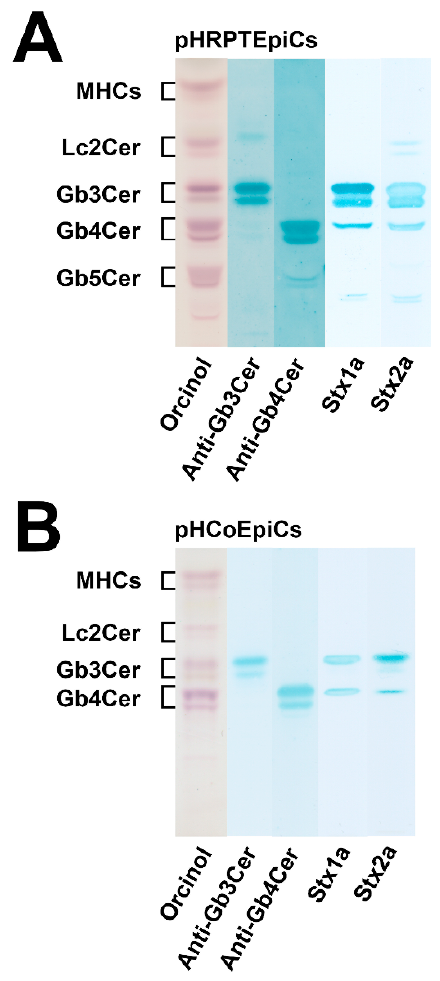
Figure 3. Orcinol stain and anti-Gb3Cer, anti-Gb4Cer, Stx1a and Stx2a TLC overlay assays of the neutral GSL preparations of pHRPTEpiCs ( A ) and pHCoEpiCs ( B ). Applied GSL amounts of pHRPTEpiCs ( A ) correspond to 5 × 10 6 cells (orcinol stain), 2 × 10 6 cells using the anti-Gb3Cer and anti-Gb4Cer antibody, respectively, and 6 × 10 5 cells for the Stx1a and Stx2a TLC overlay assay, respectively. Applied GSL amounts of pHCoEpiCs ( B ) are equivalent to 5 × 10 6 cells (orcinol stain), 5 × 10 5 cells using an anti-Gb3Cer and anti-Gb4Cer antibody, respectively, and 1 × 10 6 cells for the Stx1a and Stx2 TLC overlay assay, respectively. MHCs, monohexosylceramides. For further details refer to Detzner and collaborators [193,194], where the data were taken from. As suggested from the orcinol-stained GSLs of pHRPTEpiCs (Figure 3A), kidney epithelial cells contain almost equal amounts of Gb3Cer, Gb4Cer, and Gb5Cer as prevalent GSLs. Anti-Gb3Cer and anti-Gb4Cer TLC overlay assays gave strongly stained double bands of Gb3Cer and Gb4Cer, harboring lipoforms with sphingosine (d18:1) and C24 fatty acyl chains in the respective upper bands and lipoforms with sphingosine (d18:1) and C16 fatty acyl chains in the respective lower bands, as the predominant GSL species [193]. Stx1a and Stx2a binding assays revealed Gb3Cer as the prevalent receptor for Stx1a and Stx2a, whereas Gb4Cer, the low affinity receptor of Stx1a and Stx2a, exhibited only weak binding intensity toward the Gb4Cer variant in the upper band where Gb4Cer with sphingosine (d18:1) and C24 fatty acid separates. Both Stx subtypes did not show any binding toward Gb5Cer. The orcinol-stained GSLs in the chromatogram of pHCoEpiCs indicated a very low content Gb3Cer but a strongly stained double band of Gb4Cer (Figure 3B). This structure prediction corresponds to rather weakly anti-Gb3Cer and clearly anti-Gb4Cer positive